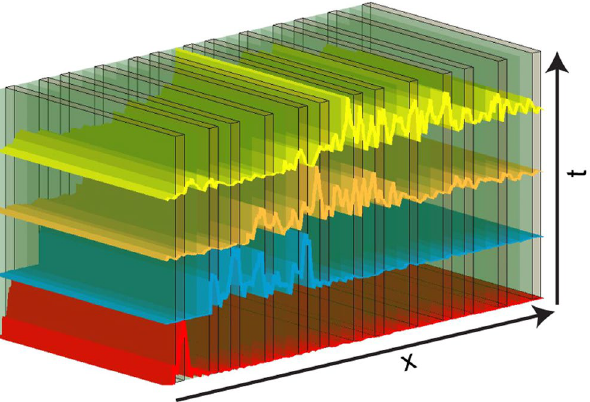
Figure 1. Schematic of a set of scattering layers with representative fractal pulse shapes displayed at different